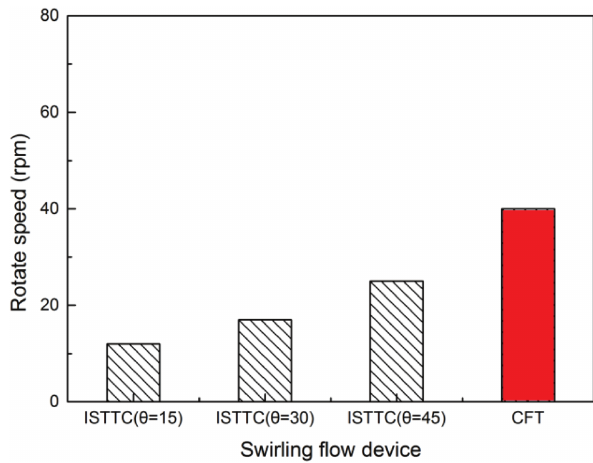
Figure 14: The maximum rotate speed in swirling flow driven by different swirling flow